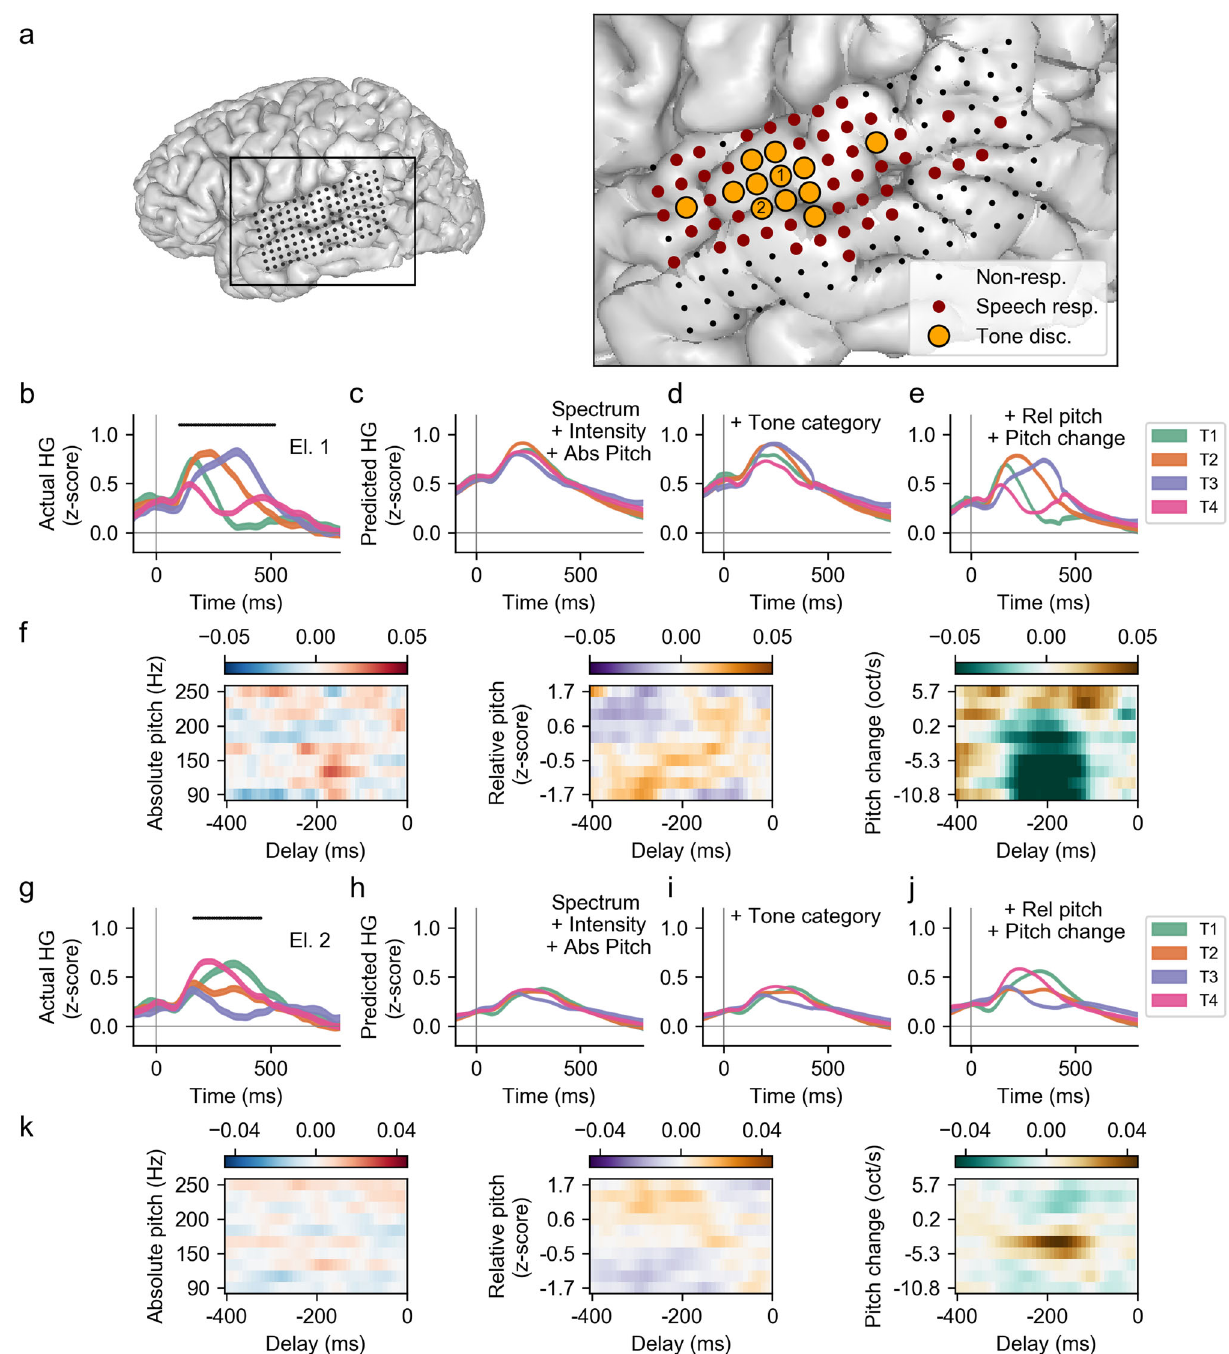
Fig. 2 Mandarin lexical tones evoke differential neural responses at single STG electrodes, explained by tuning to speaker-normalized pitch features. a Electrode locations for one participant. Dark red indicates electrodes that were responsive to speech. Circled orange electrodes had signi fi cantly different response patterns to different tones. b The actual high-gamma (HG) responses from a single example electrode (Electrode 1 in a ) that differentiates lexical tones. Average neural activity (shaded area represents mean ± s.e.m.) in response to each tone is plotted, aligned to vowel onset. Black lines indicate time points where means are signi fi cantly different between tones ( P < 0.05, F test, two-tailed, Bonferroni corrected). c The predicted responses from an encoding model using spectrum, intensity and absolute pitch features. d The predicted responses by adding tone category features to the model in c . e The predicted responses from the full encoding model where speaker-normalized pitch features are included. f The temporal receptive fi eld (regression weights) from the model with regard to absolute pitch, relative pitch height and pitch change, indicating selectivity to positive pitch change. g – k Same as b – e , but for Electrode 2, which is tuned to negative pitch